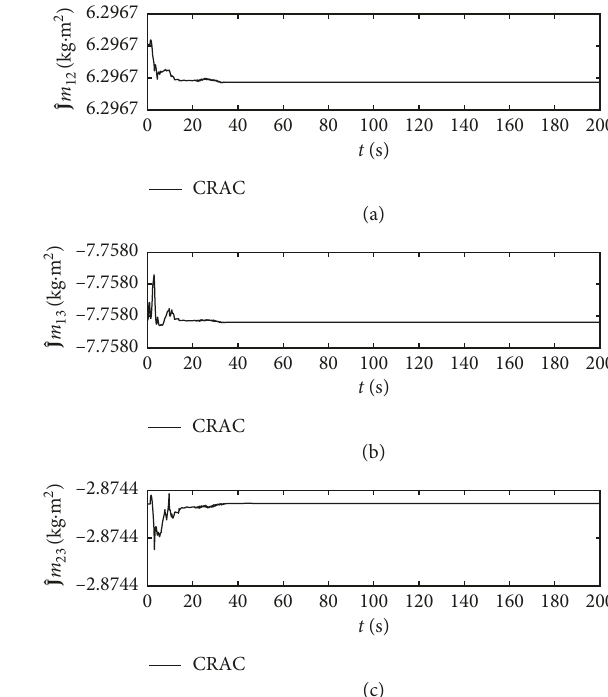
Figure 10: Time response of estimated parameters of the product of inertia in Case